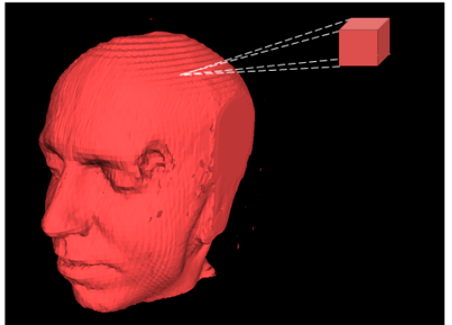
Figure 2. 3D human head model, constructed by marching cubes method (the original source file of this figure is [12]).